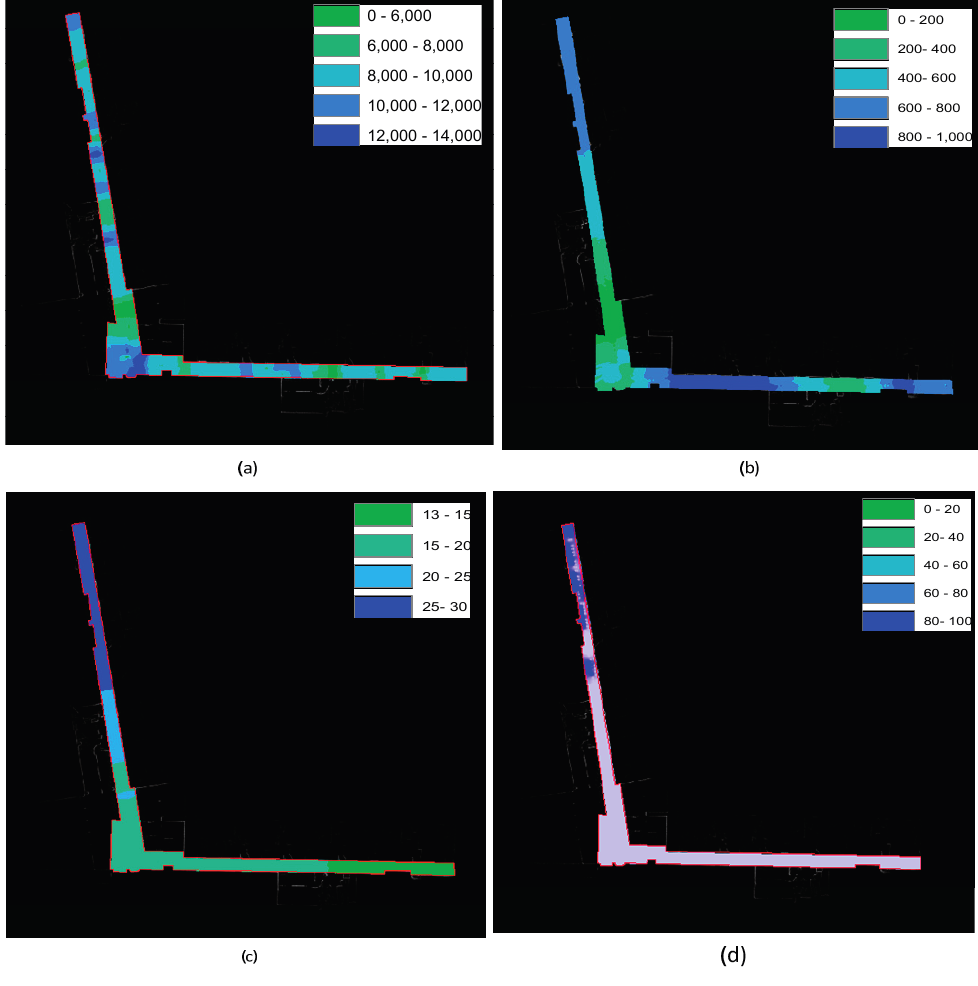
Figure 10. ( a ) Grid map result of magnetic field intensity distribution; ( b ) grid map result of light intensity distribution; ( c ) grid map of WiFi access point number distribution; ( d ) grid map of intensity distribution of one WiFi access